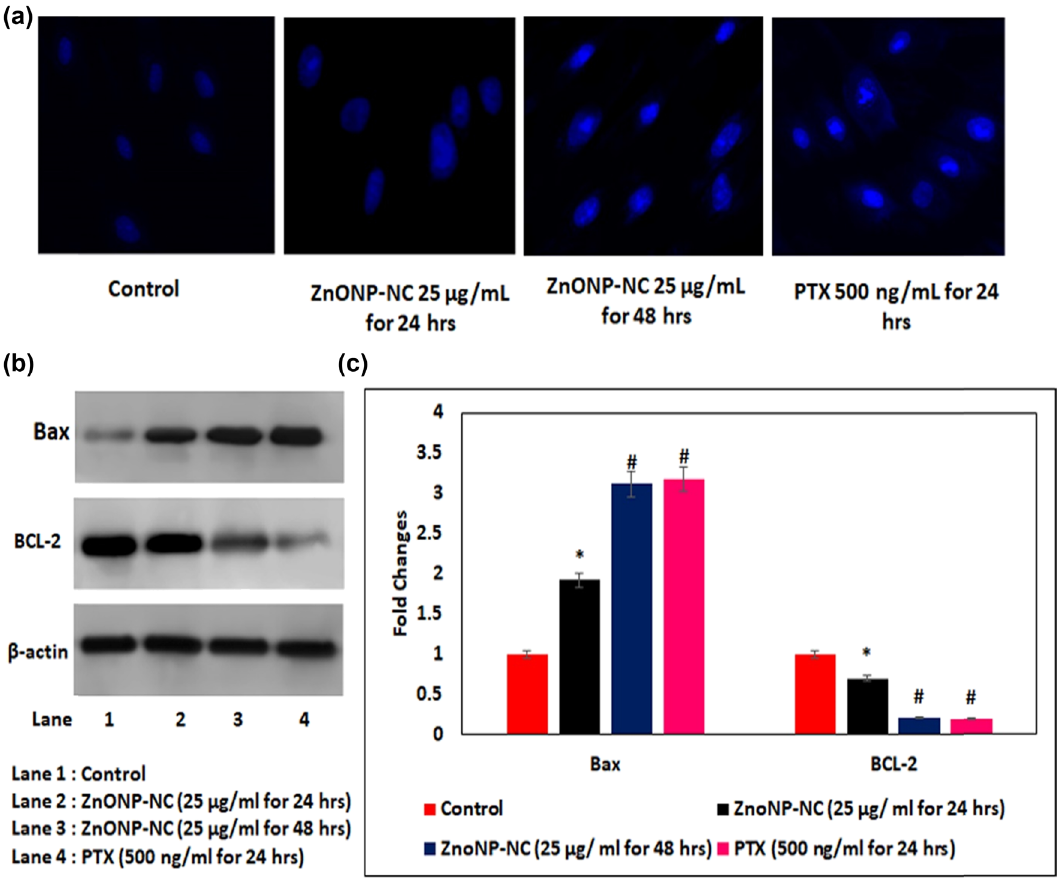
Figure 6: ZnONPs - NC inducenuclearfragmentation - mediated apoptosis inSKOV3cells: ( a ) microscopic images ofZnONPs - NC treatment shows increased the nuclear condensation in SKOV3 cells con fi rmed by Hoechst staining; ( b ) ZnONPs - NC treatment - associated apoptotic gene ( Bax and Bcl - 2 ) expression was studied by western blotting; ( c ) quanti fi cation of protein was evaluated by image - J software, and β - actin has served as positive control; it can normalize the interest of protein. Values from the plot are expressed as mean ± SD calculated by